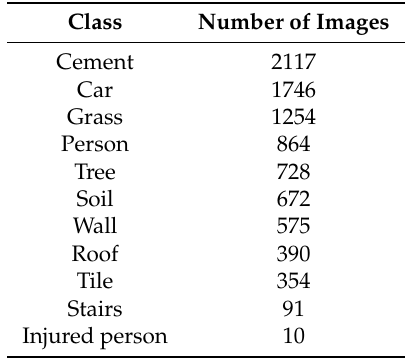
Table 1. Number of images in which each class is